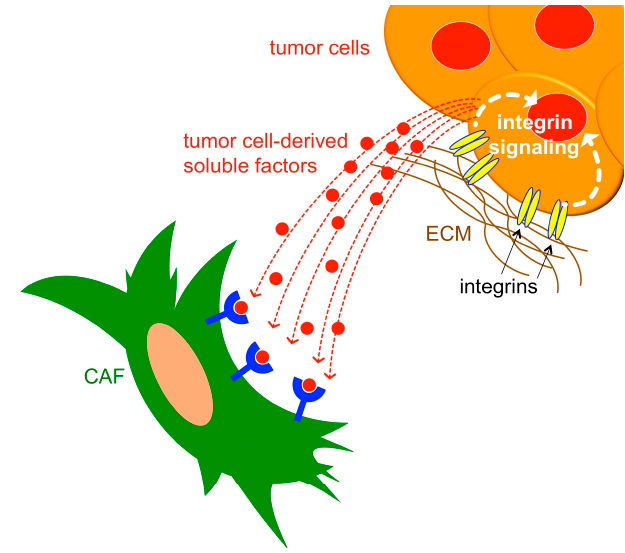
Figure 3. Integrins expressed on tumor cells regulate the expression/secretion of paracrine-acting factors that stimulate CAFs, in some cases, through binding to receptors expressed on the CAF surface. ECM, extracellular matrix; CAFs, cancer-associated fibroblasts.